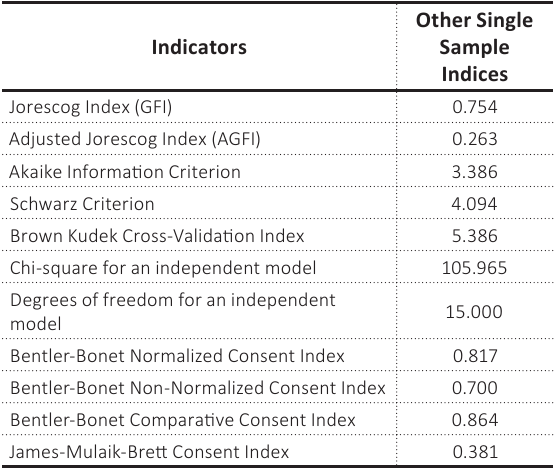
Table 7. Single Sample Indices of the relationship between NPLs of banking institutions,